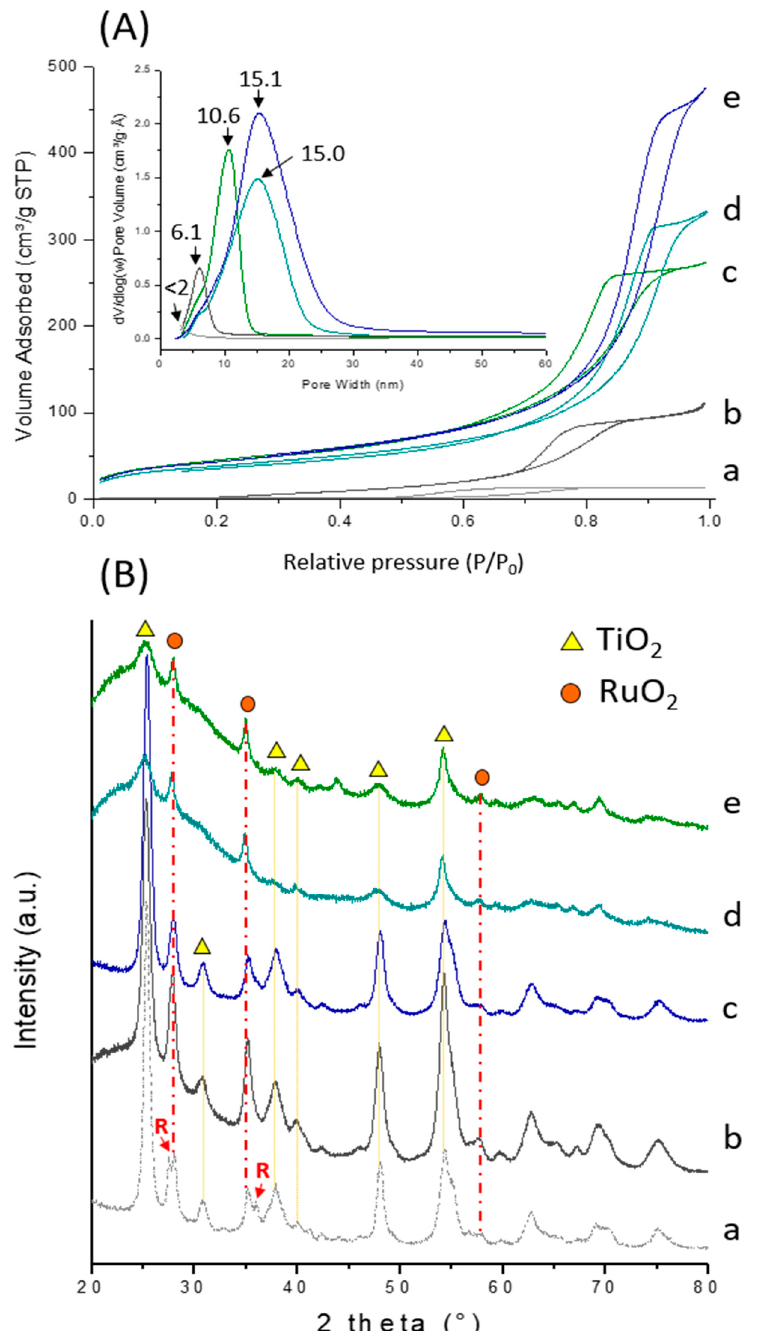
Figure 4. N 2 adsorption isotherms and corresponding pore size distributions (inset) ( A ) and XRD patterns ( B ) of RuO 2 @TiO 2 -sg (a), RuO 2 @TiO 2 -ns (b), RuO 2 @TiO 2 -SiO 2 3:1-ns (c), RuO 2 @TiO 2 -SiO 2 3:2-ns (d), and RuO 2 @TiO 2 -SiO 2 3:3-ns (e). “R” denotes the rutile phase.